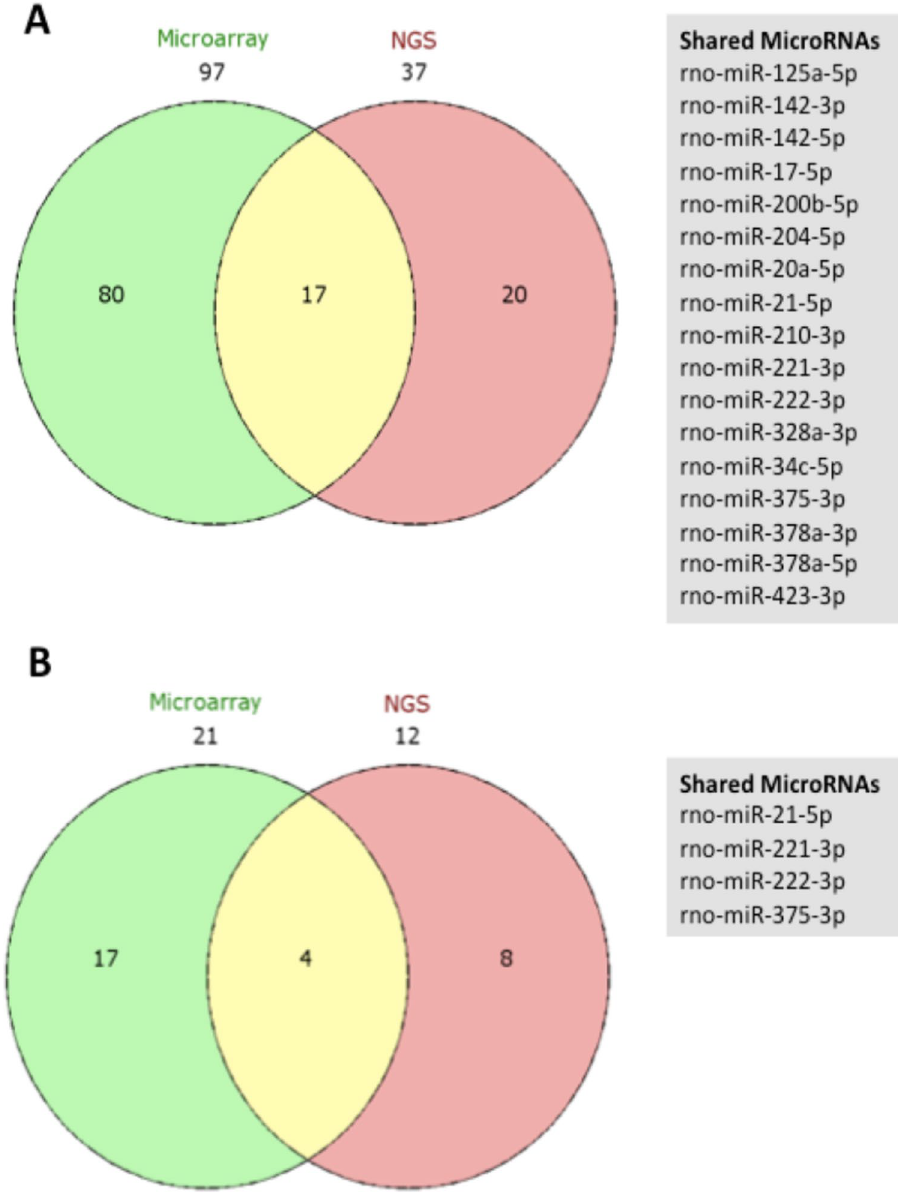
Figure 6. Comparison of Microarray and Next Generation Sequencing analyses. RNA extracted from whole kidney tissue of bilateral sham, 45 min IRI, IPC alone, and IPC-IRI in rats at 48 h after reperfusion underwent Exiqon Microarray (n = 5 each) and Next generation Sequencing (NGS) analyses (pooled samples n = 1 each). Venn diagrams (A) and (B) show the overlap between Microarray and NGS of differentially expressed microRNAs in ‘Sham v IRI’ and ‘IRI v IPC/IRI’